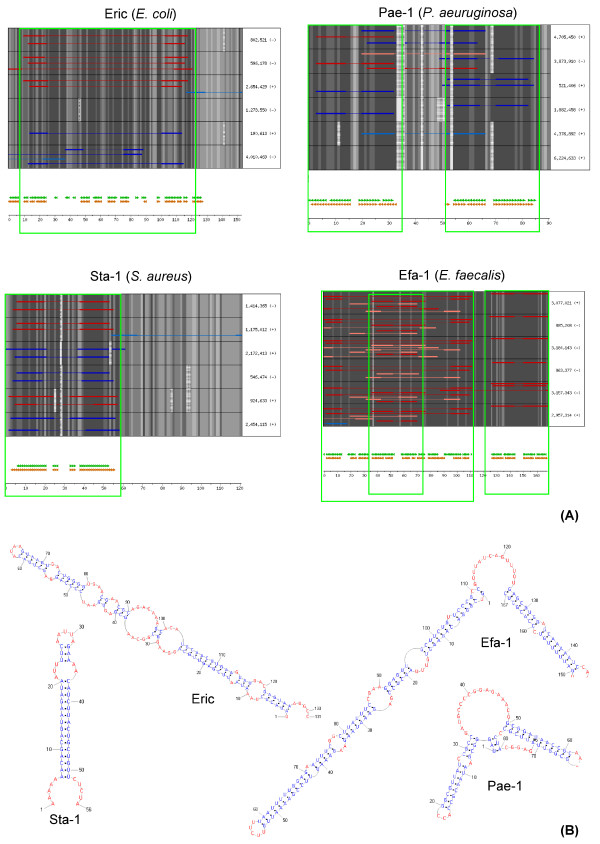
Alignment of ERIC, Pae-1, Sta-1 and Efa-1 family members. (A) A representative set elements from each family was aligned by using the HMM model as a guide. In each panel, one row corresponds to one family member (indicated on the right with its genomic position). Within each row, sequence conservation is indicated by increasing gray levels and gaps by dotted spaces; overlapping SLSs are reported as red and blue lines, the red ones indicating SLSs used to define the original HMM model for the family, the blue all the others. Darker colors indicate the SLS folding aptitude, i.e. positivity to RANDFOLD for P <= 0.005. Common secondary structures, predicted by RNAz, are reported at the bottom, just above the ruler in nucleotides: green triangles indicate stems produced by pairing complementary regions on the same strand as the identified SLSs, while brown triangles indicate the same from the opposite strand. The boxed regions highlight areas where aligned SLSs and predicted structures are in agreement. (B) Graphic representation of the RNAz predicted secondary structures.